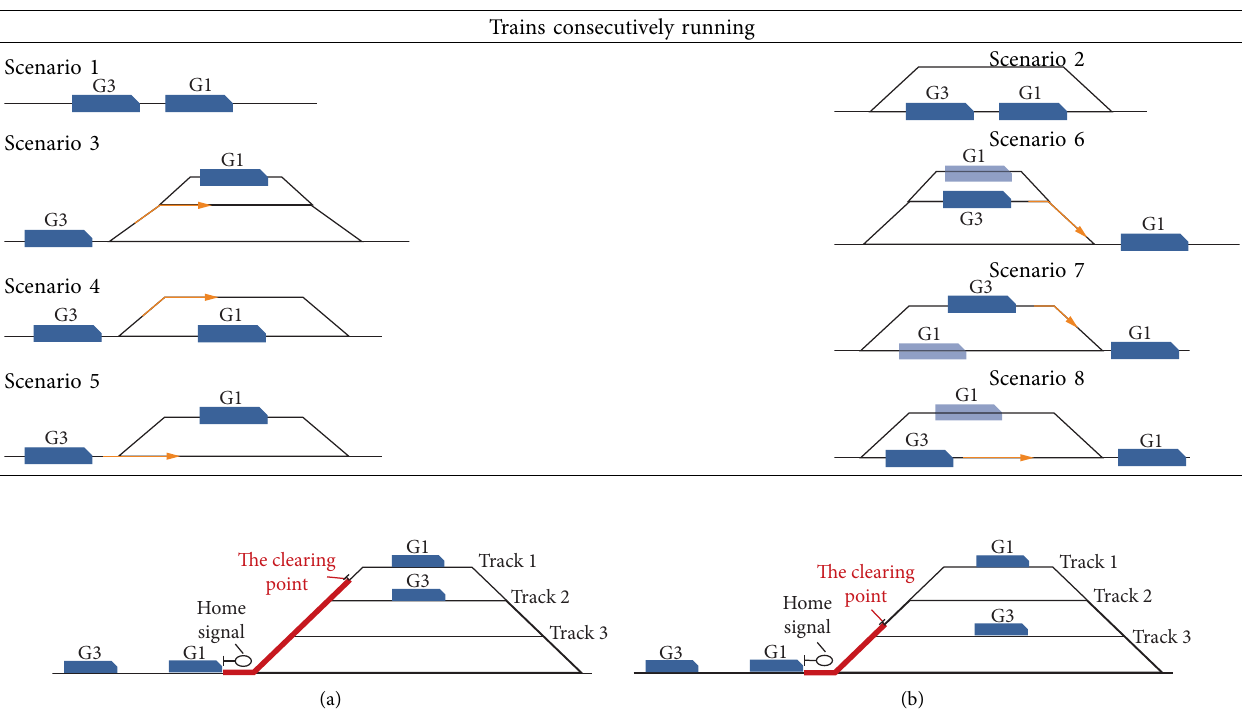
Table 2: Train manoeuvre scenarios under VC system.